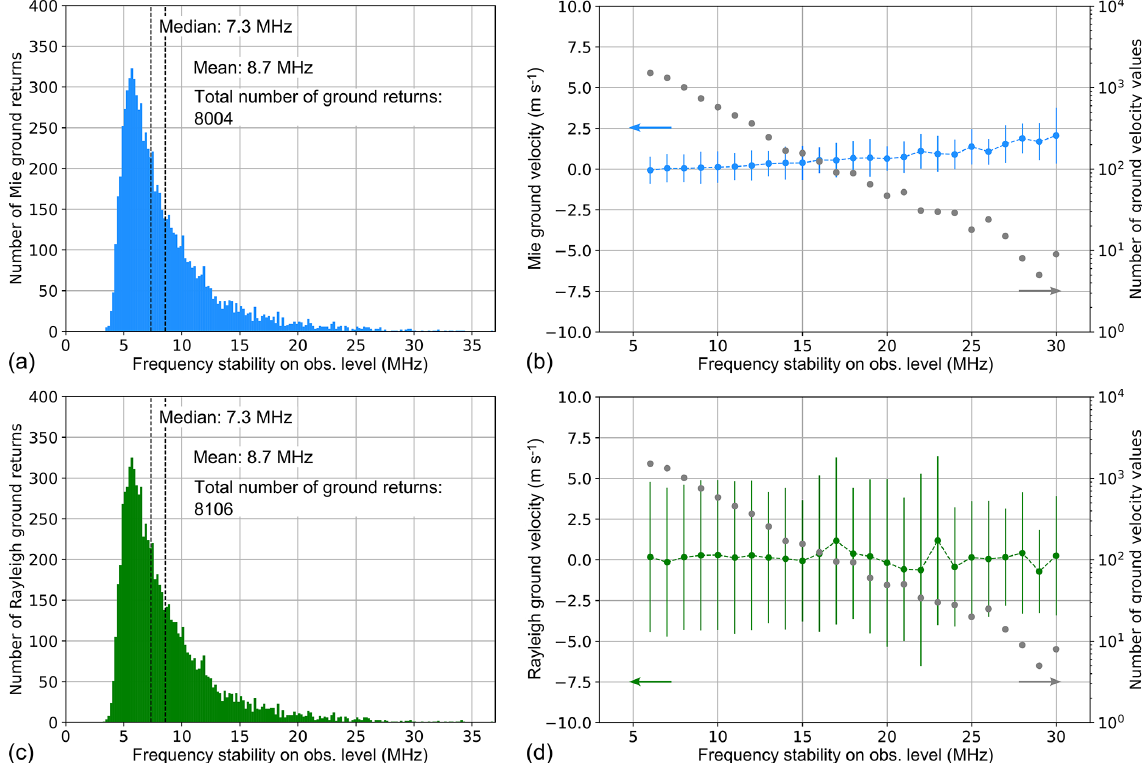
Figure 14. Histograms of the laser frequency stability on the observation level for those observations that yielded valid Mie ground returns during the combined periods from 17 to 24 August 2020 and from 28 September to 5 October 2020. (b) Mean Mie ground velocity in dependence on the frequency stability. The ground velocities were subtracted by the mean over all values for which the frequency stability is better than 8MHz for the sake of comparability. A data point plotted versus a frequency stability of k represents the mean over all ground velocities for which the stability is in the interval between ( k − 1)MHz and k MHz, while the error bar represents the corresponding standard deviation. The number of ground velocity values within each interval is shown in gray. The bottom panels (c) and (d) depict the corresponding statistics for the Rayleigh ground